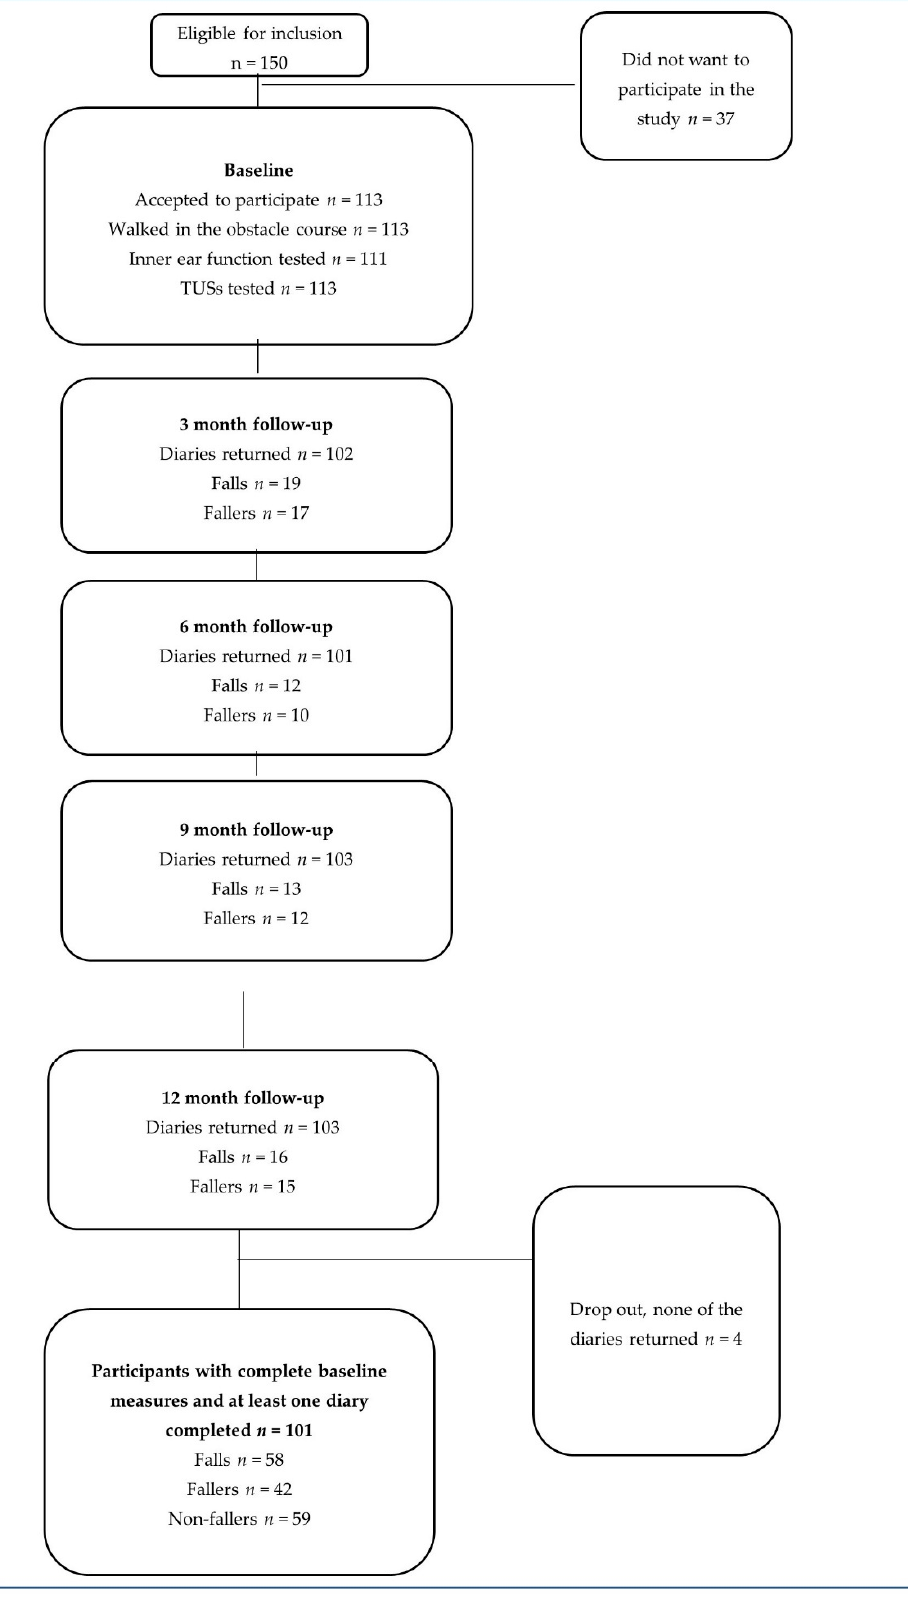
Figure 4. Flow chart of the study.